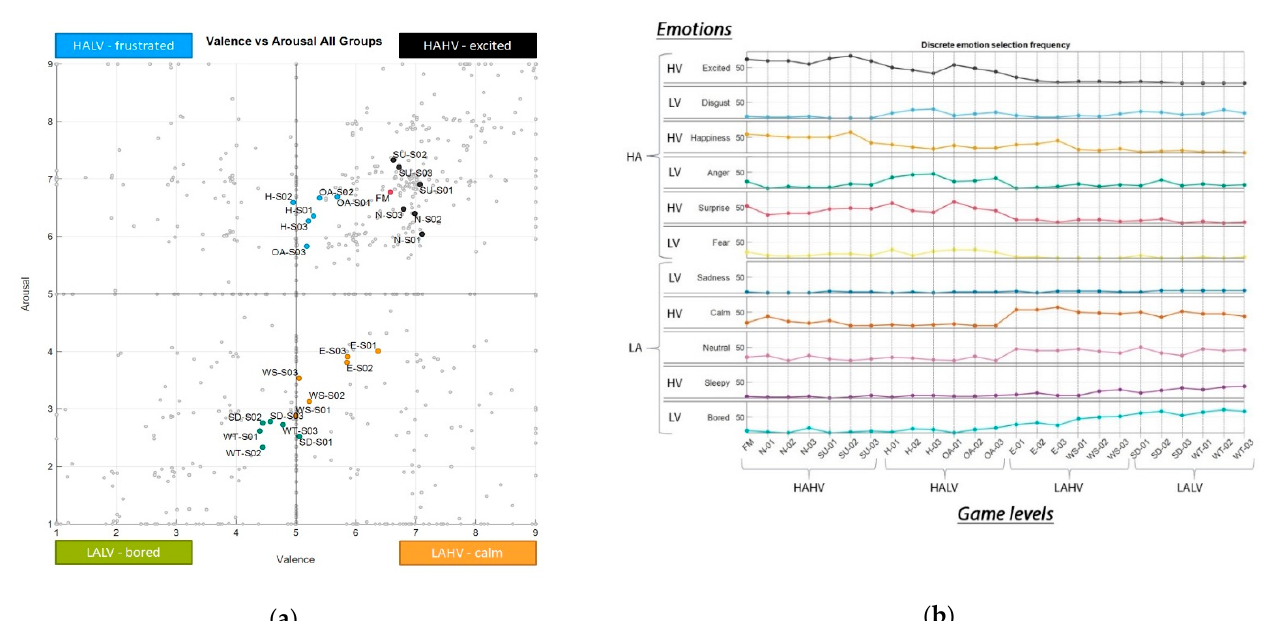
Figure A4. ( a ) Arousal–valence dispersion. Levels names: N—normal, SU—speed up, H—hard, OA—only asteroids, E— easy, WS—without speed, SD—speed down, WT—without tokens. Stage names: S01—Stage 01, S02—Stage 02, S03—Stage 03. The colors are related to the emotional quadrants that we intent to induce: HAHV—black, HALV—blue, LAHV—orange, LALV—green. ( b ).